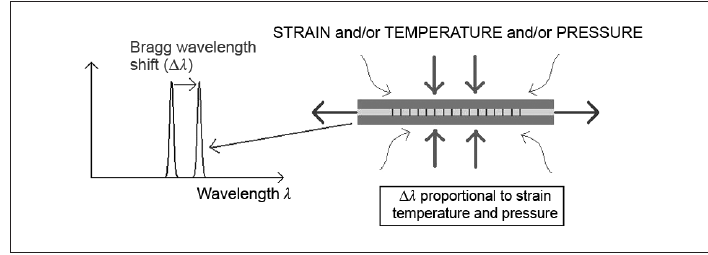
Fig. 2. Strain, temperature and pressure effects on a Bragg grating reflection